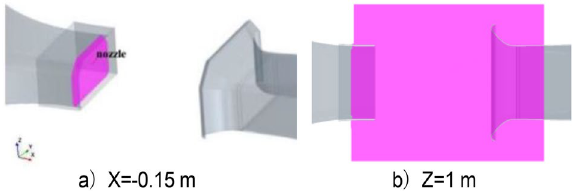
Figure 4. The layout of the sampling plane.